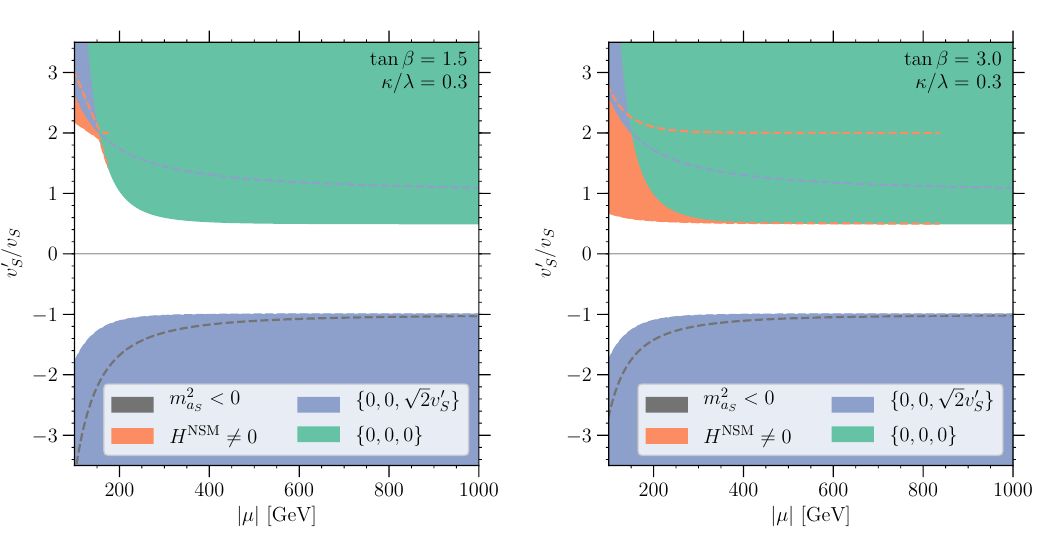
Figure 2 . Same as figure 1 but for κ/λ = 0 . 1 .